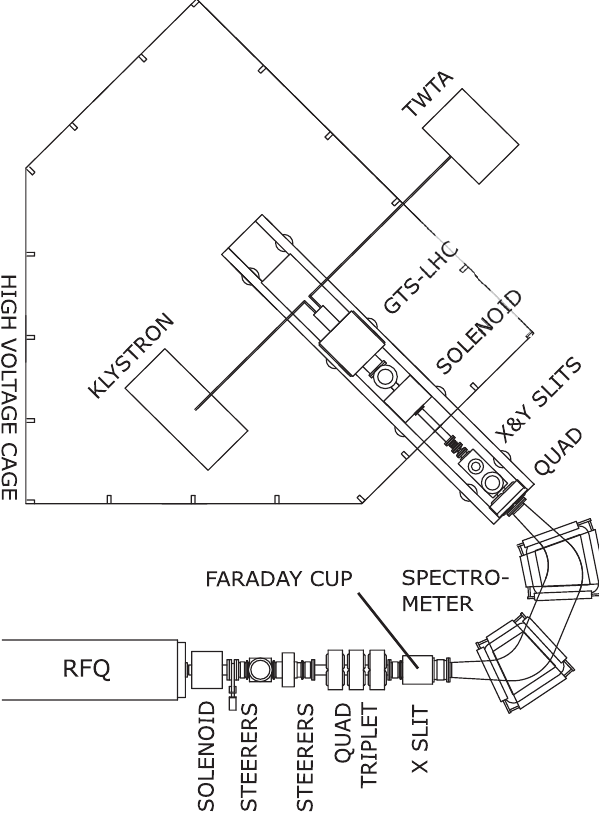
FIG. 4. Layout of Linac3 low energy beam transport section, from the ion source to the entrance of the RFQ. The main ion optical elements and beam diagnostics are also